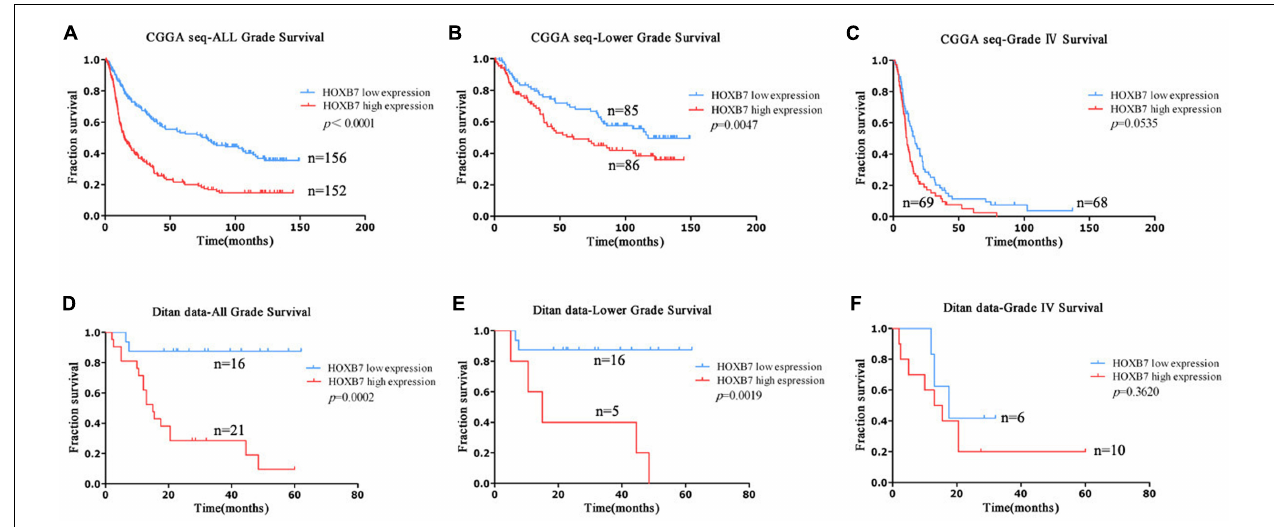
FIGURE 3 | Prognostic significance of HOXB7 in all-grade, lower-grade and GBM groups. (A–C) CGGA RNA-seq database; (D–F) Ditan database.